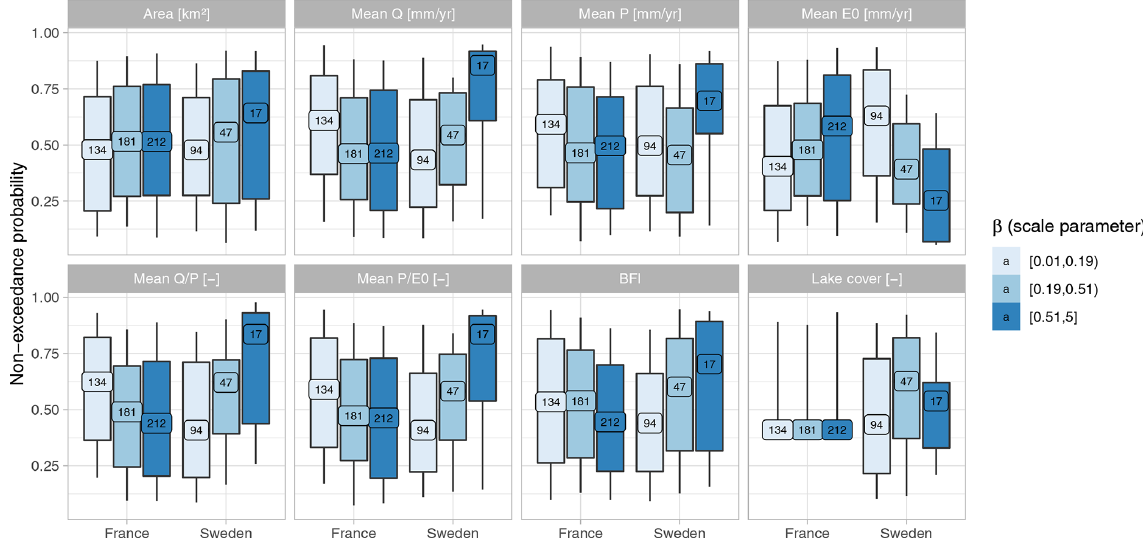
Figure B3. Distribution of hydroclimatic characteristics according to three classes of the scale parameter β of the Gamma distribution (Eq. 3) calibrated inside Eq. (2). The classes are delimited by quantile values. The numbers within each boxplot describe the number of